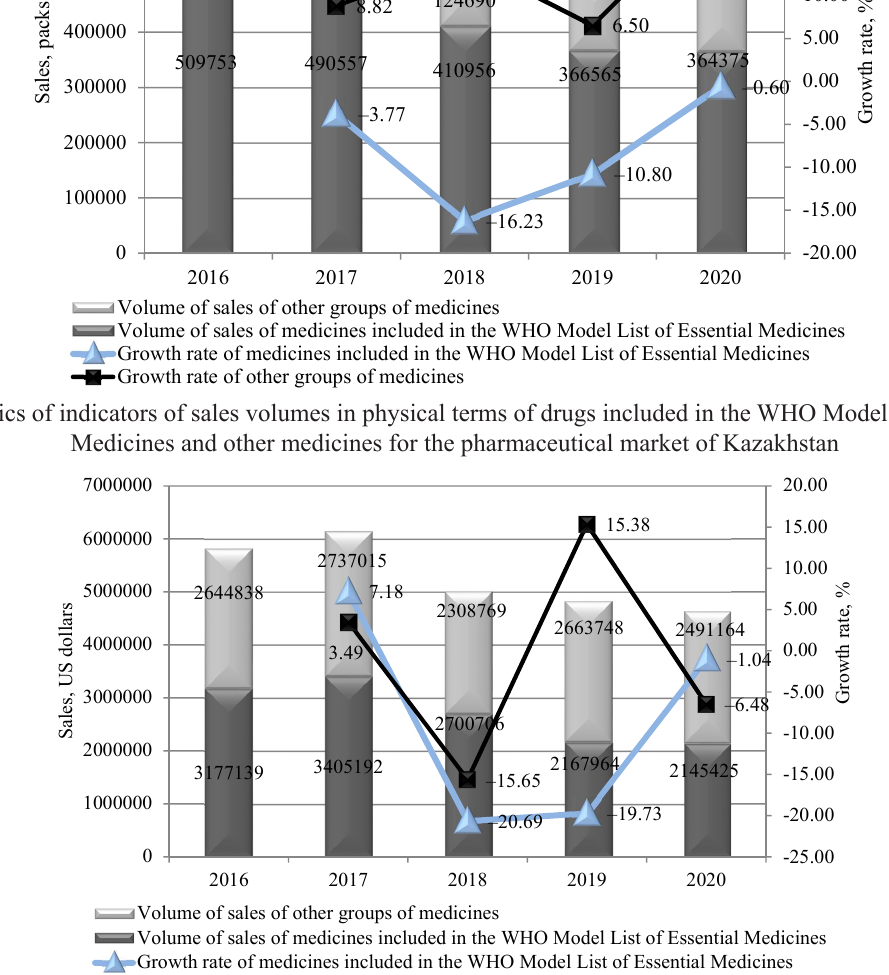
Volume of sales of other groups of medicines Volume of sales of medicines included in the WHO Model List of Essential Medicines Growth rate of medicines included in the WHO Model List of Essential Medicines Growth rate of other groups of Fig. 10. Dynamics of indicators of sales volumes in cash of drugs included in the WHO Model List of Essential Medicines and other medicines for the pharmaceutical market of Kazakhstan